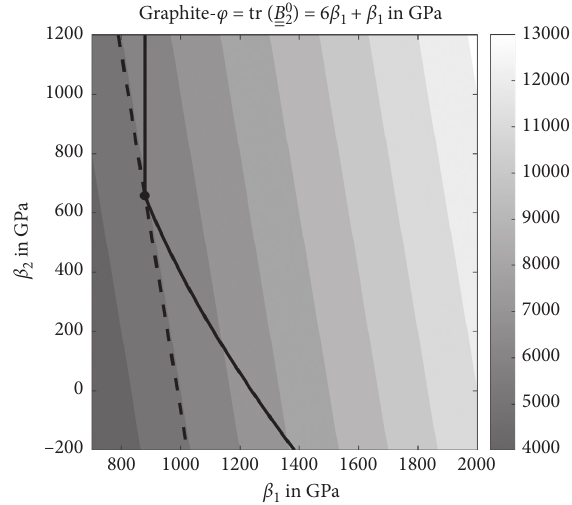
Figure 12: Computation of upper zeroth-order bound of [16] 0 ) � 6 β + β based on φ � tr ( B for graphite (instance of Lemma 1 2 � 2 (black line), minimum of φ over B 2.2): z B 2 ( c ) − 1 ) ∈ z B (black point), and φ � min ( Q 2